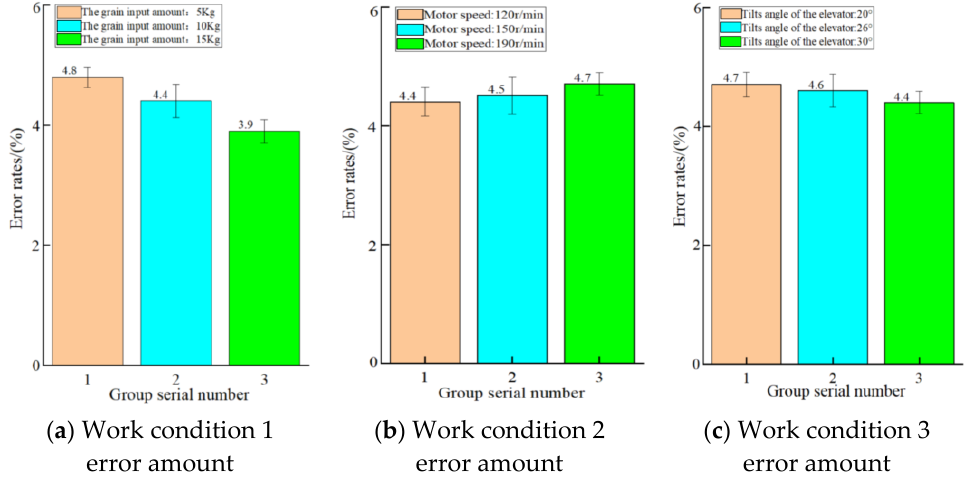
Figure 7. Relative error value of calculated mass and actual weighing